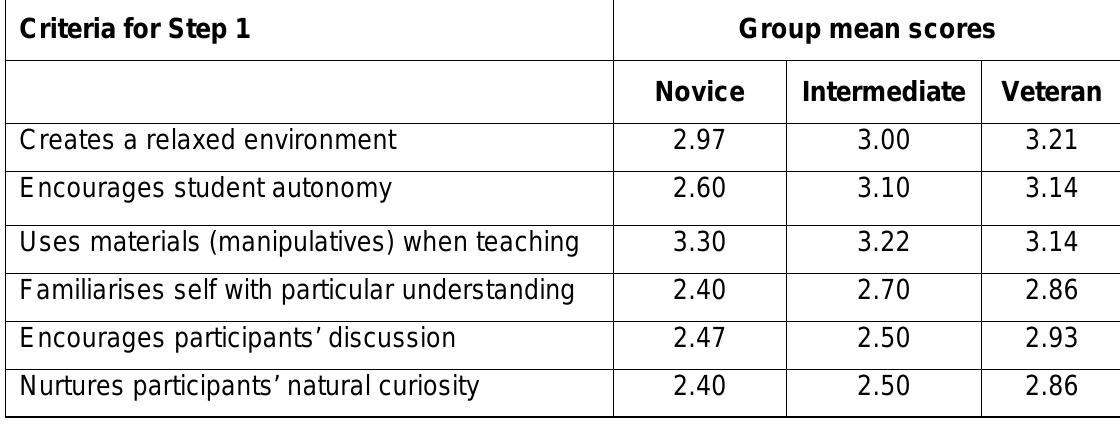
Comparison of mean facilitator scores, across facilitator categories, on their ability to engage participants in problem-solving